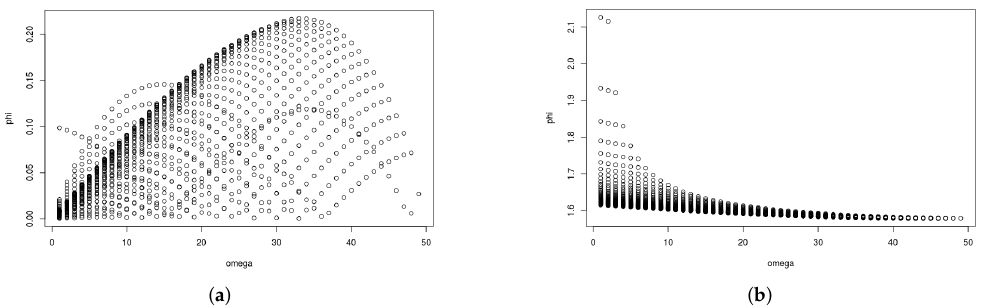
Figure 7. Cross method results. ( a ) φ jk s against ω jk s from R HPC de-composited by the AHPC method. ( b ) φ jk s against ω jk s from R MHPC de-composited by the HPC